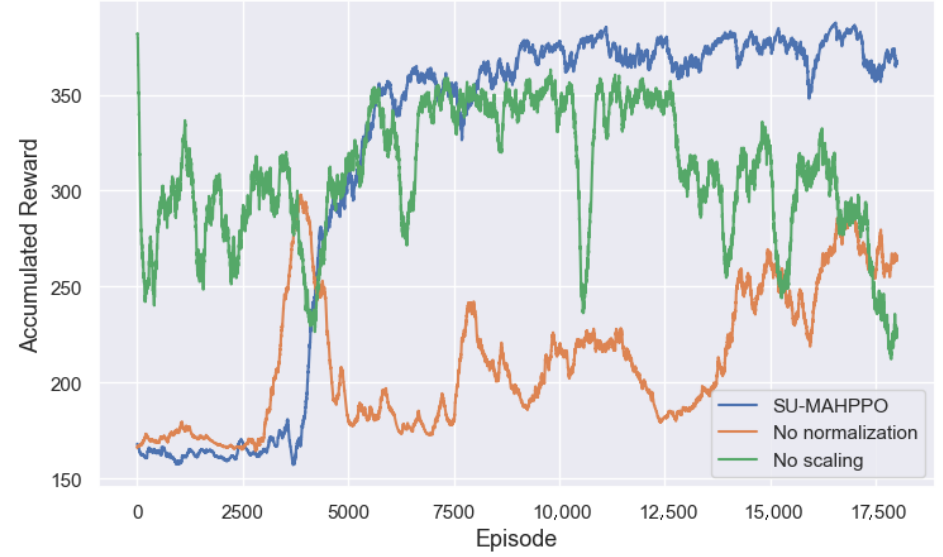
Figure 4. Convergence without state and action normalization and reward